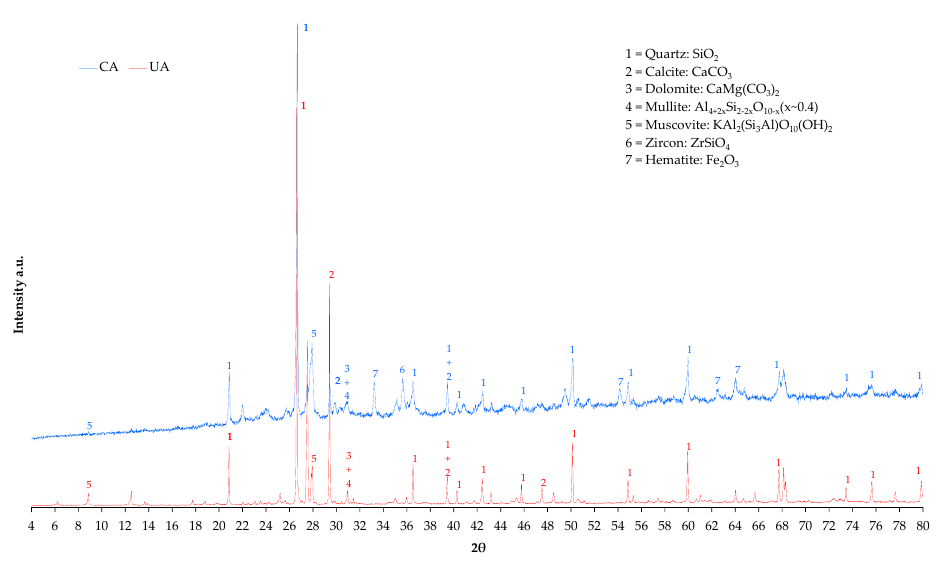
Figure 2. XRD diffractogram for the CA and UA studied.